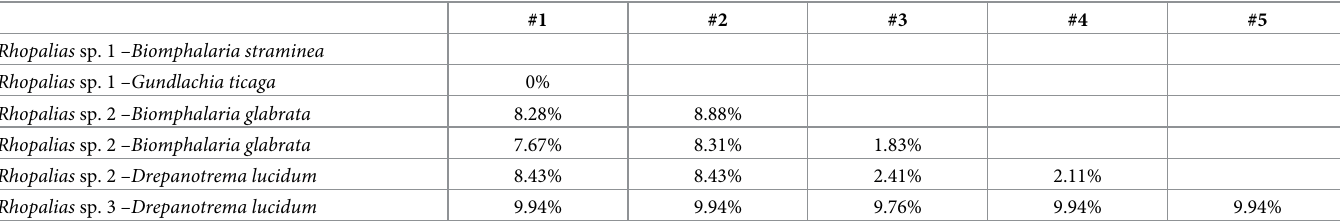
Table 2. Pairwise distances (uncorrected p-distance) based on nad 1 sequences obtained from cercariae of Rhopalias spp. found in planorbid snails from